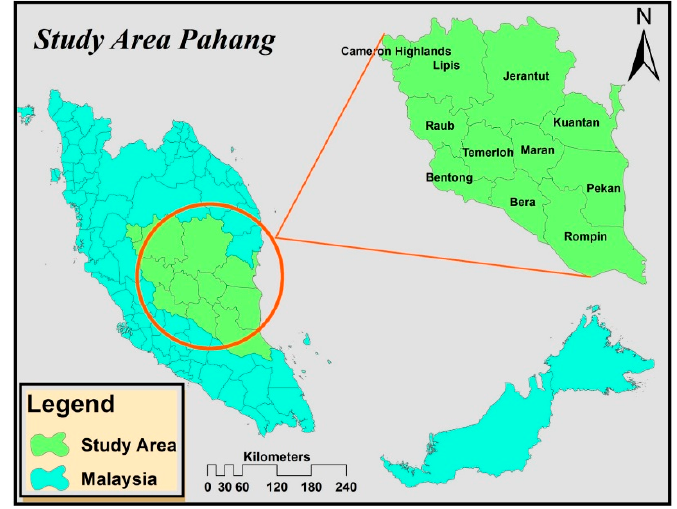
Figure 1. Study area.